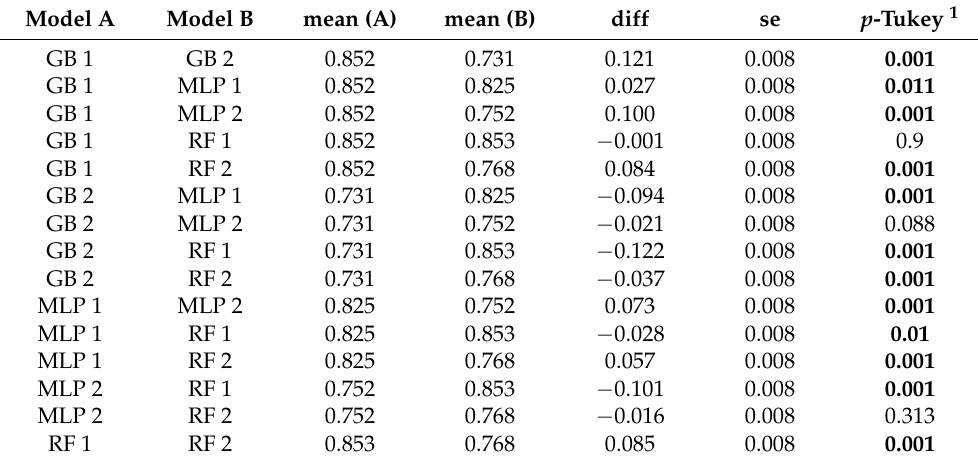
Table 6. Statistical Evaluation of the machine learning models. Numbers 1 and 2 correspond to original-dataset and modified-dataset respectively.